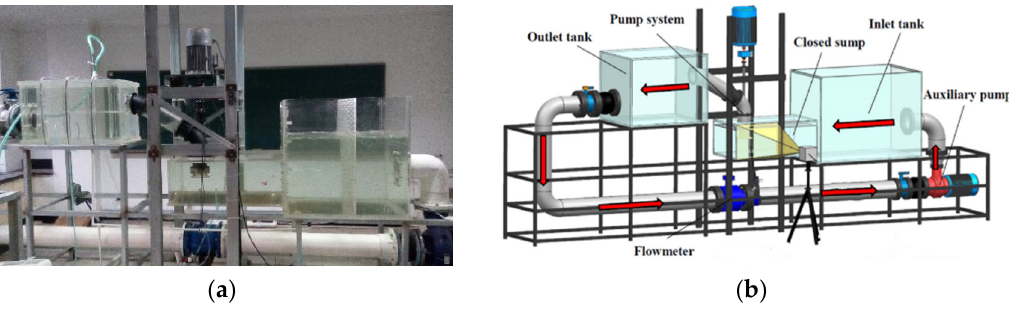
Figure 22. Test rig. ( a ) Test model and ( b ) 3D model.